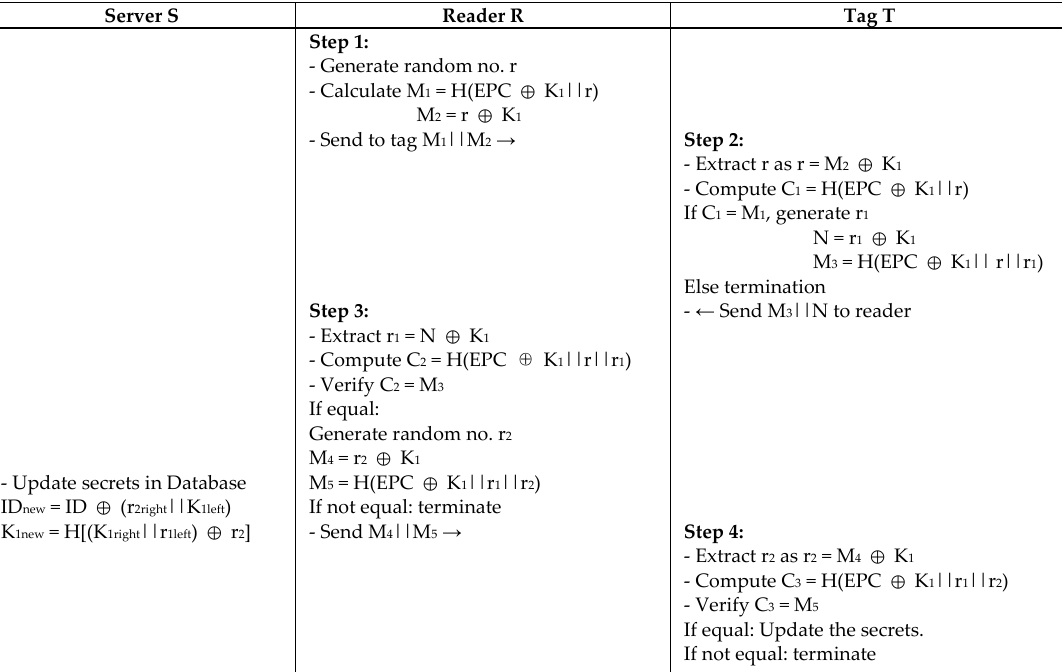
Figure 8. Mutual Authentication Protocol for Networked RFID Systems (NRS++) by X. Chen.